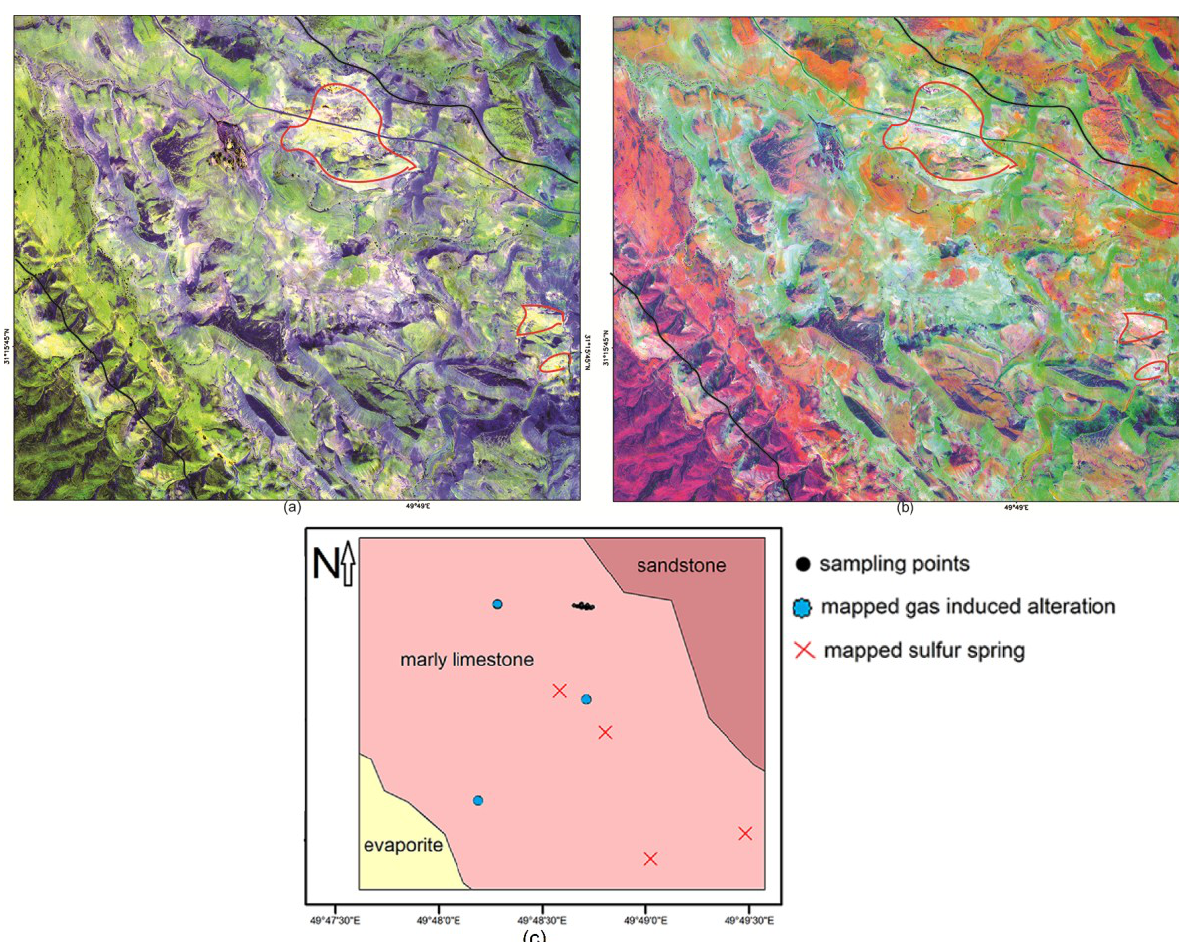
Figure 8. ( a ) FCC image created from Band 2/Band 1 (in red), Band 5 + Band 3/Band 1 (in green), and Band 4/Band 8 (in blue); ( b ) an FCC of PCA123 (principal component analysis (PCA)) from the WV-2 bands. Red ellipses surround alteration zones, and black lines display lithological boundaries. ( c ) The geological map of the study